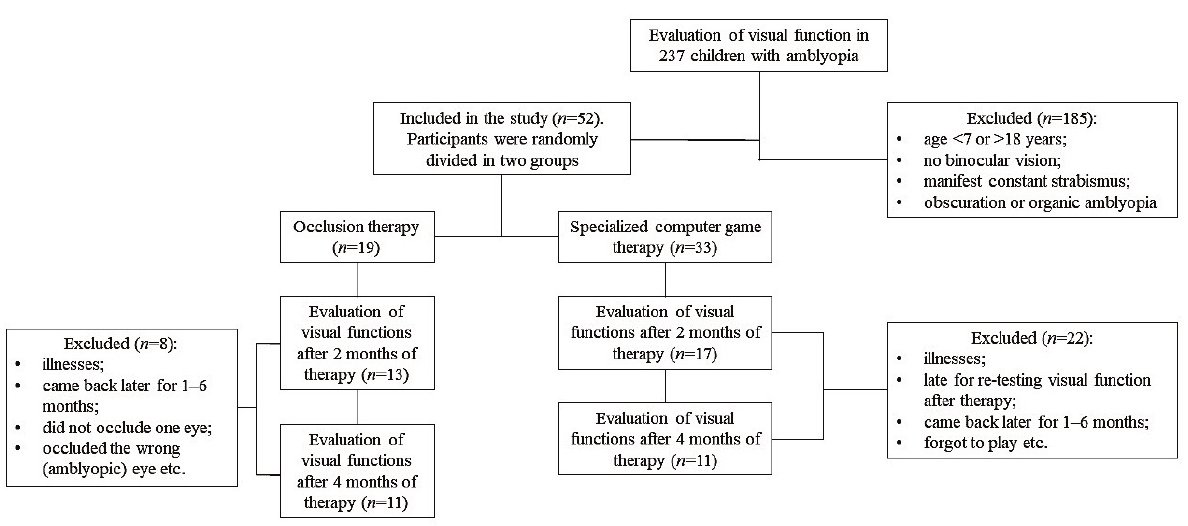
Fig. 1. Flowchart of the selection process and treatment process over a period of 4